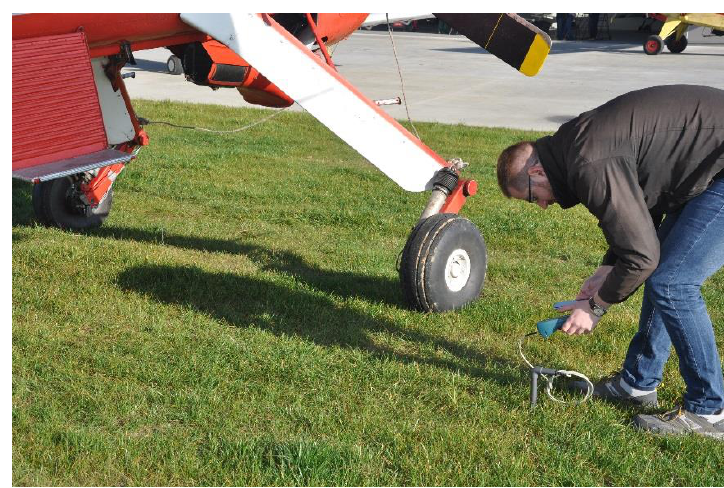
Figure 7. Measurement of soil moisture with the use of a handheld time-domain reflectometry (TDR) sensor.